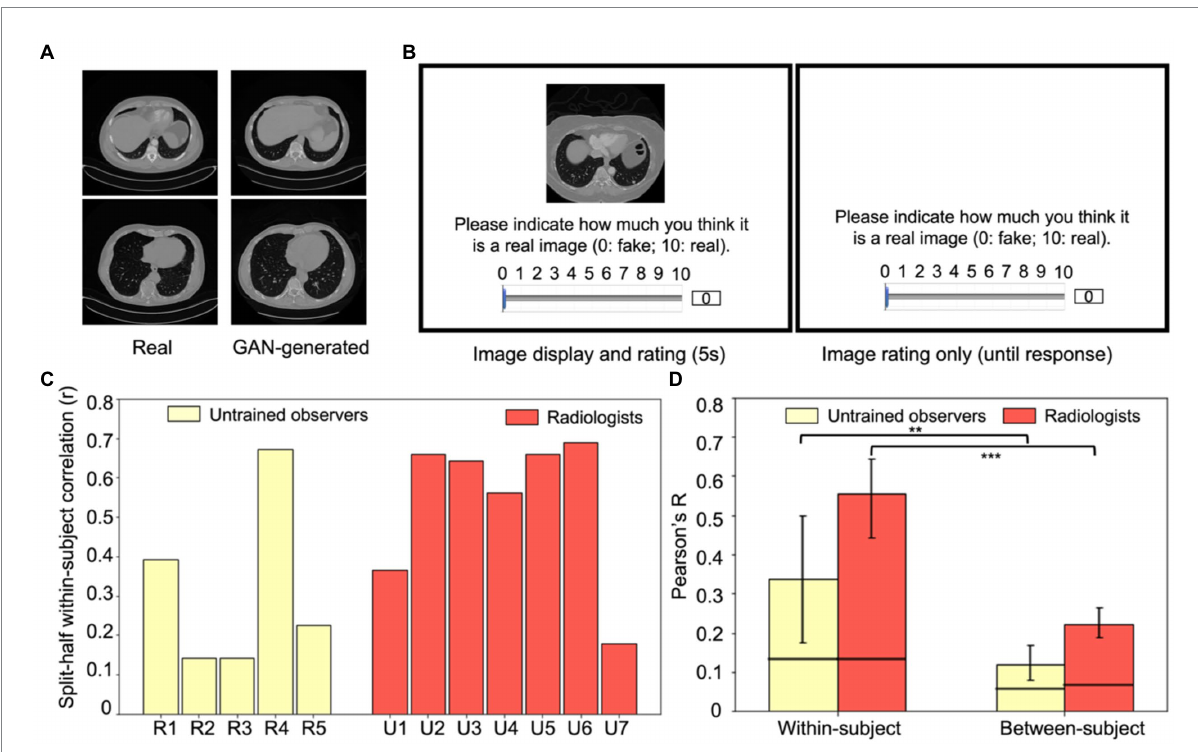
FIGURE 4 Experiment 2 example stimuli and results. (A) Examples of real (left column) and GAN-generated (right column) CT lesion images used in the experiment. Visually and qualitatively the images are similar, and a previous study showed that these GAN-generated images were visually metameric: they were indistinguishably realistic to both radiologists and untrained observers (Ren et al., 2022). (B) An example trial in Experiment 2. On each trial, either a real CT lesion image or a GAN-generated image was shown on the screen for at most 5 s. Participants could rate the realness of the image from 0 to 10 (0: fake, 10: real) anytime during the image presentation or after the disappearance of the image (self-paced). The next trial began after the rating was made. (C) Within-subject consistency for each radiologist and untrained observer, calculated from the split-half correlation of each observer’s response errors of the same images. (D) Within-subject correlations significantly exceeded between- subject correlations for both groups ( p < 0.01 for untrained observers and p < 0.001 for radiologists), which replicated the individual differences found in Experiment 1 and extended the results to a new task, a new type of medical image, and with more realistic stimuli. Error bars represent the 95% bootstrapped CIs and the horizontal lines represent the 97.5% upper bounds of the permuted null distribution. ** p < 0.01, *** p <